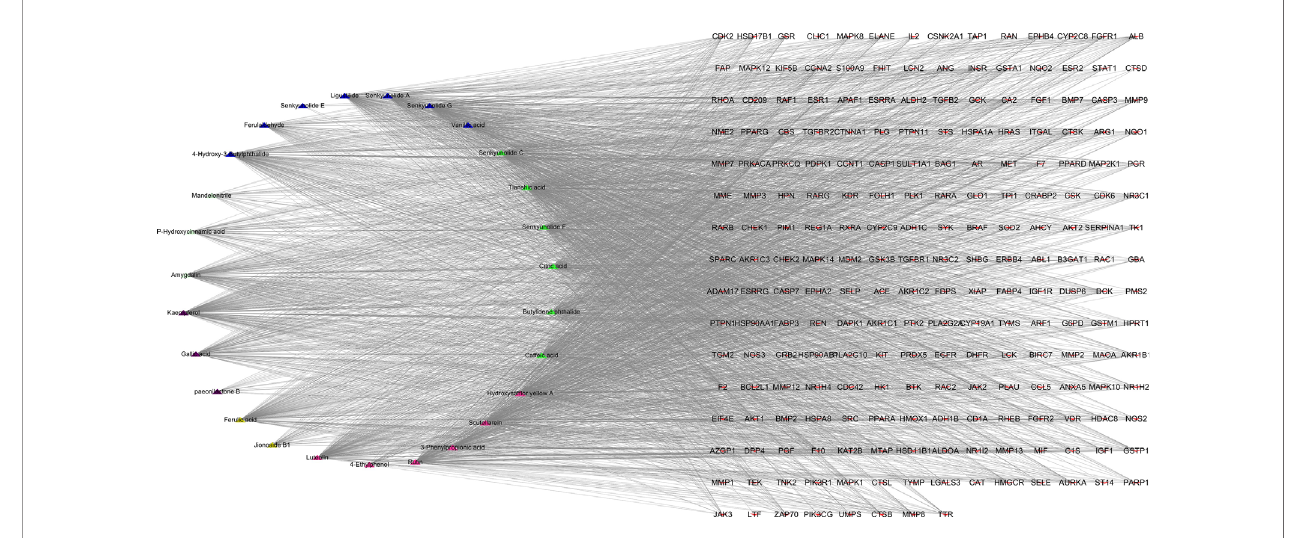
FIGURE 2 | “ Components-targets ” interaction network.